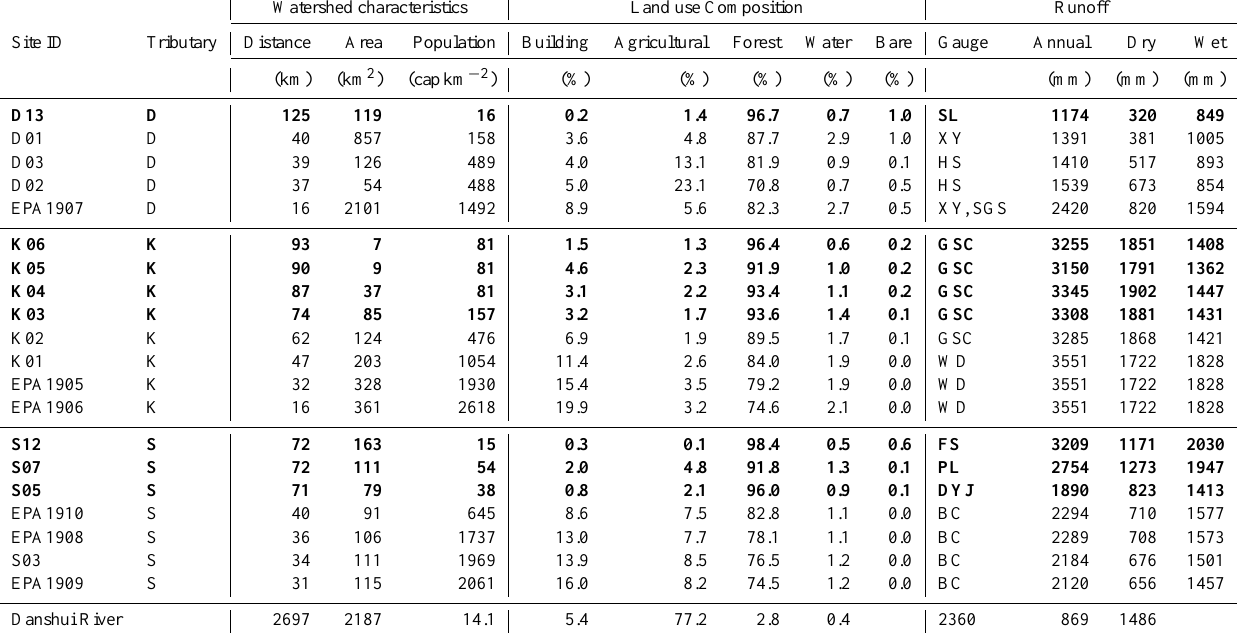
Table 1. Watershed characteristics, land use compositions, discharge and rainfall for each sampling site. Sites are arranged in sequence according to their distances to the estuary. Upstream sites (distance to the estuary > 70km) are in bold. The distance is measured from the shoreline. The tidal excursion distance is ∼ 10–20km upriver, depending on tidal range and weather conditions. Bare land use usually includes landslide and